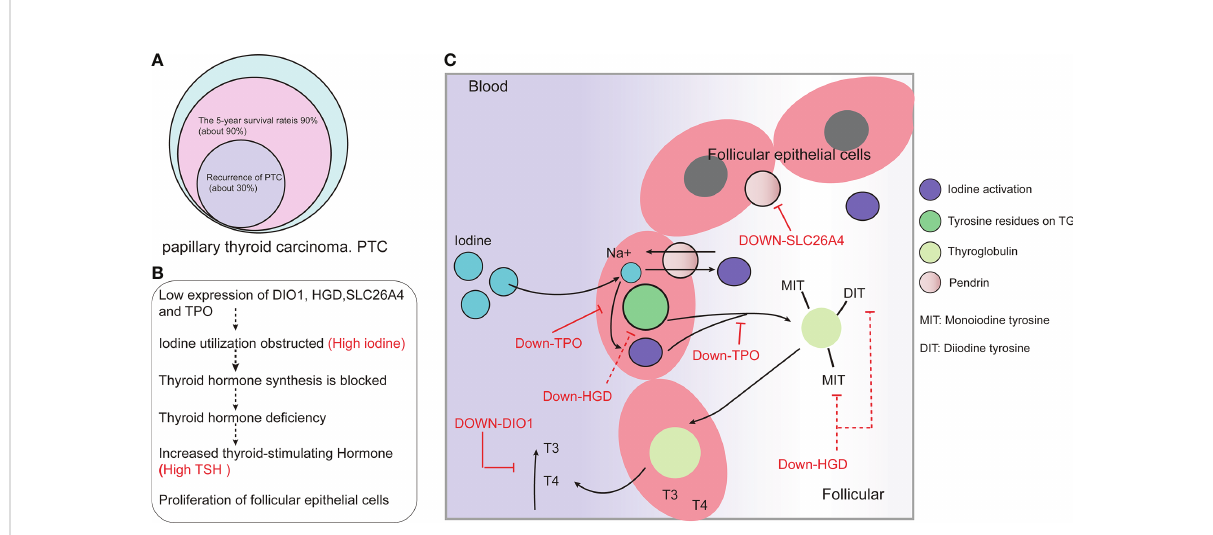
FIGURE 7 DIO1 , HGD , SLC26A4 , and TPO might be involved in the development of papillary thyroid carcinoma (PTC) by affects the absorption and utilization of iodine. (A) Prognosis of and recurrence rate in PTC patients. (B) Low expression of DIO1, HGD, SLC26A4 and TPO may affect the synthesis and utilization of thyroid hormones. (C) The possible mechanism of iodine-resistant radiotherapy in patients with metastatic PTC: The low expression of DIO1, HGD, SLC26A4 , and TPO leads to the inhibition of iodine recycling and thyroid hormone